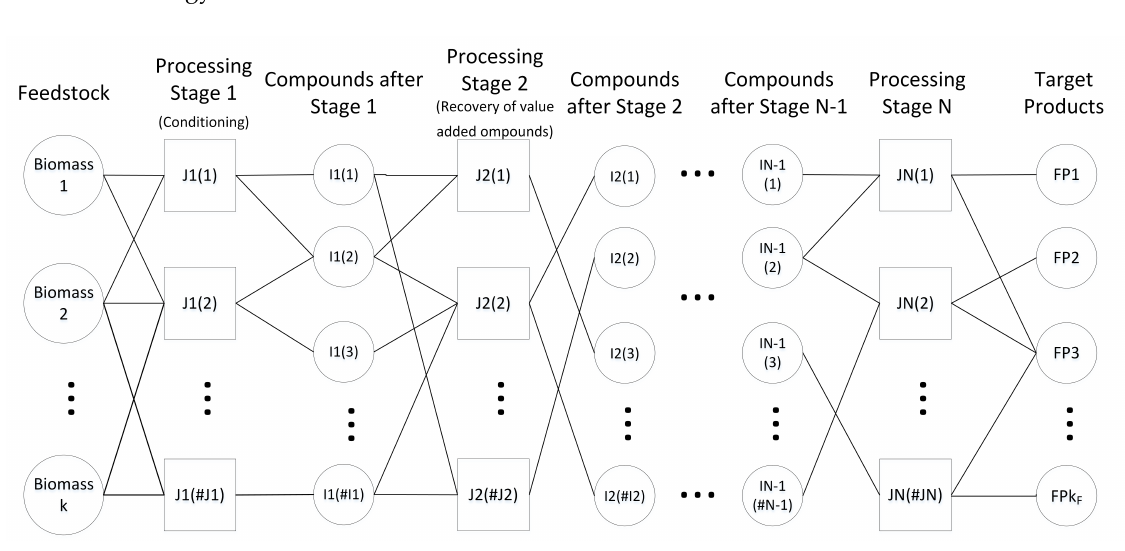
Figure 3. A generic processing